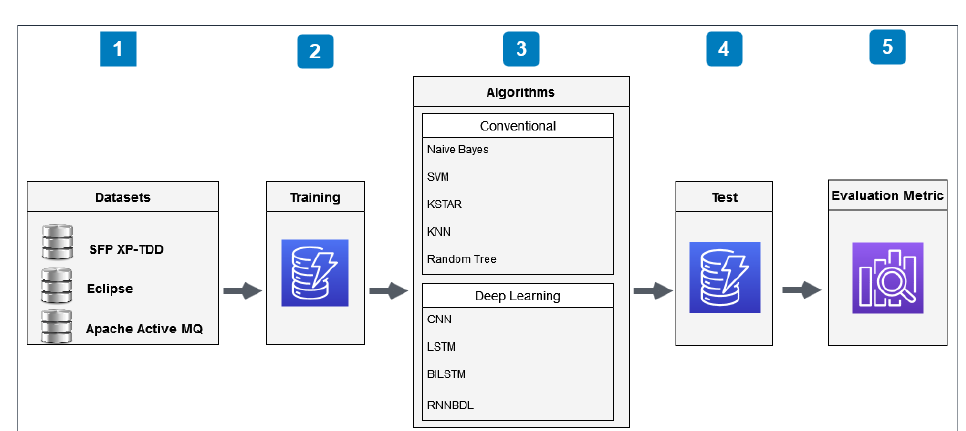
Figure 2. The pipeline of the workflow and its complete architecture. Algorithm 1. Pseudo-code of the proposed scheme.